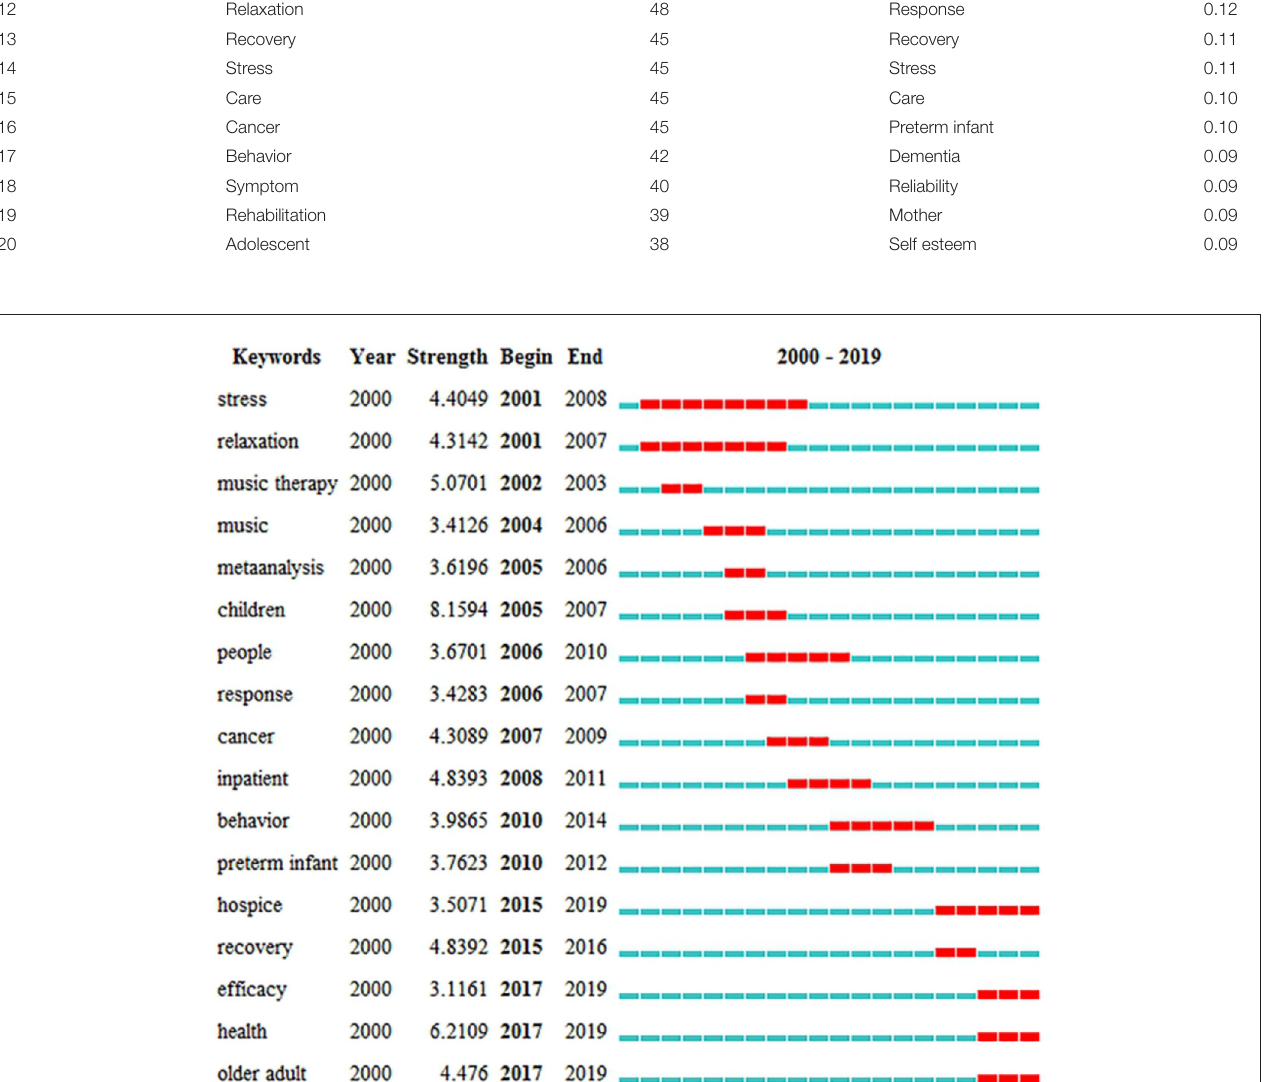
FIGURE 8 | The strongest citation bursts of the top 17 keywords. The red measures indicate frequent citation of keywords, and the green measures indicate infrequent citation of keywords.